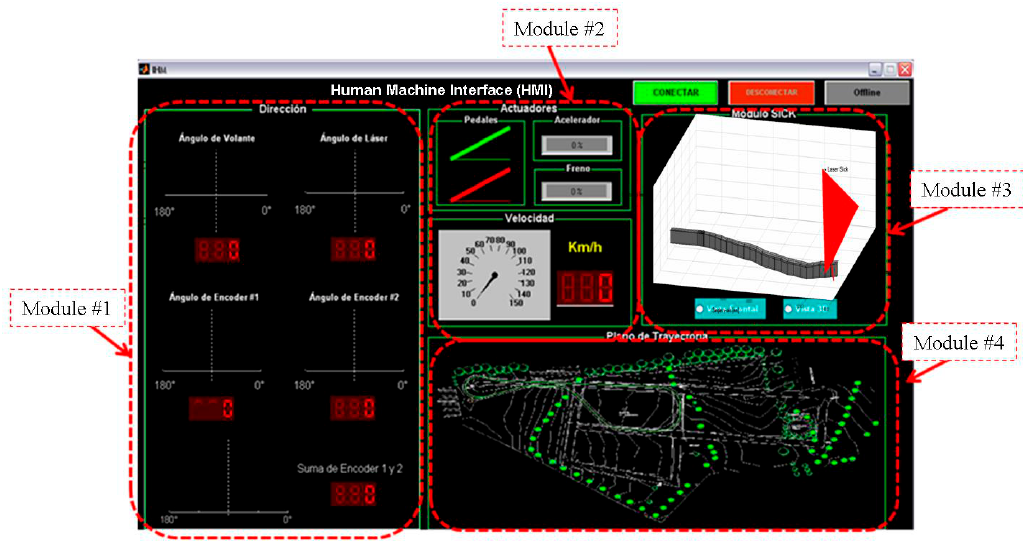
Figure 9. HMI graphical environment.